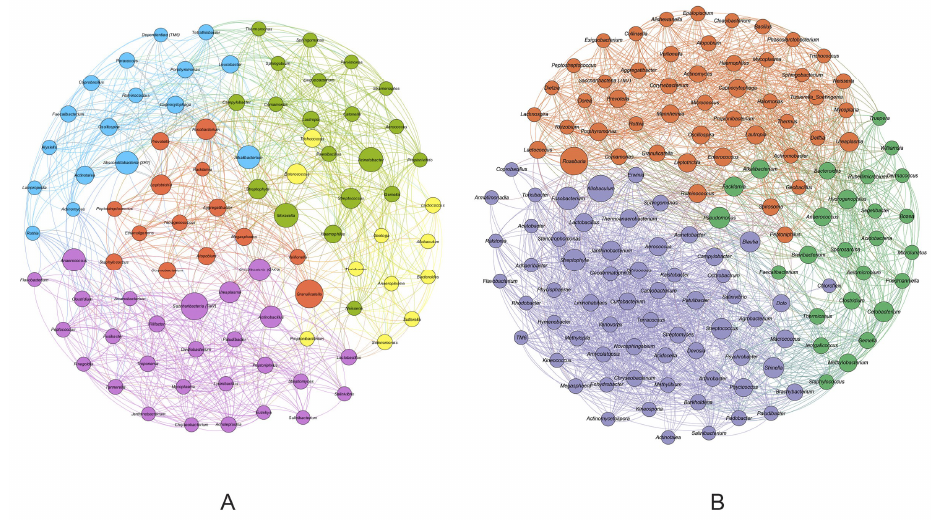
Figure 2. Modular network analysis of the bacterial taxa identified from ( A ) brushtail possums’ and ( B ) stoats’ oral microbiota. Node coloursrepresent the co-occurring bacterial taxa (modules). The node sizes are proportional to the degree of between centrality, and edges are coloured based on the node of